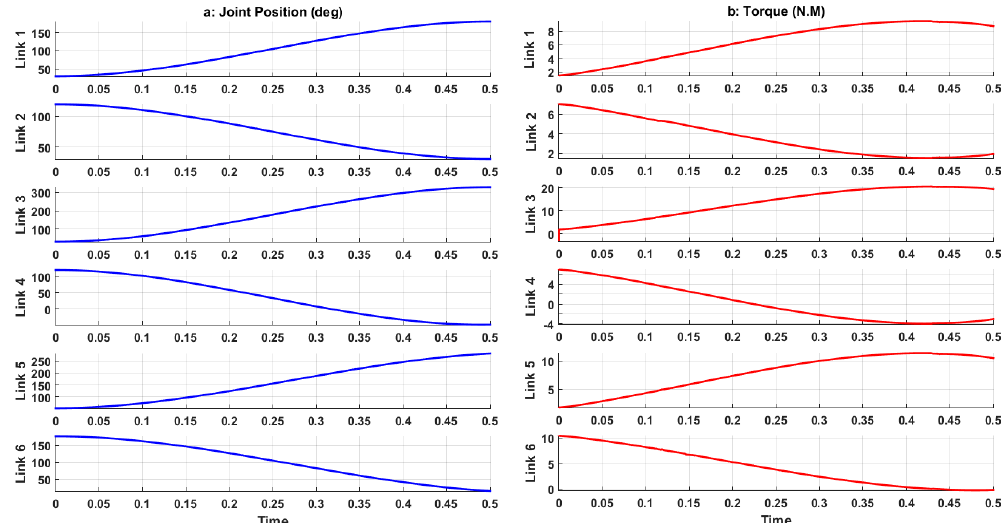
Figure 9. Input and output signals in the normal condition ( a ) Joint variable signals and ( b ) torque signals.